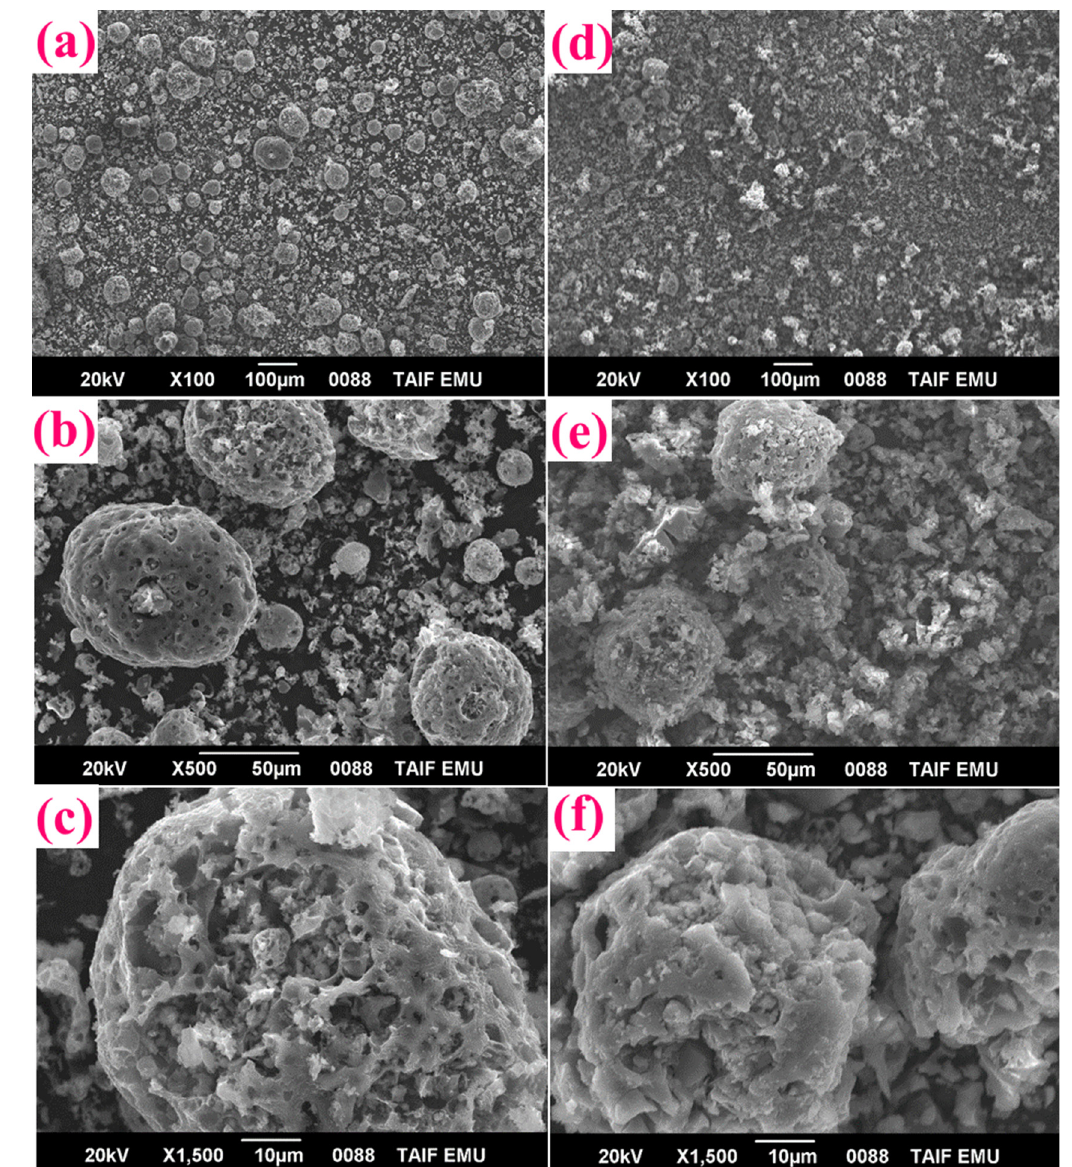
Figure 2. SEM micrographs of the outer surface of ( a – c ) original FA and ( d – f ) FA-TiO 2 cenospheres, taken at different magnifications.